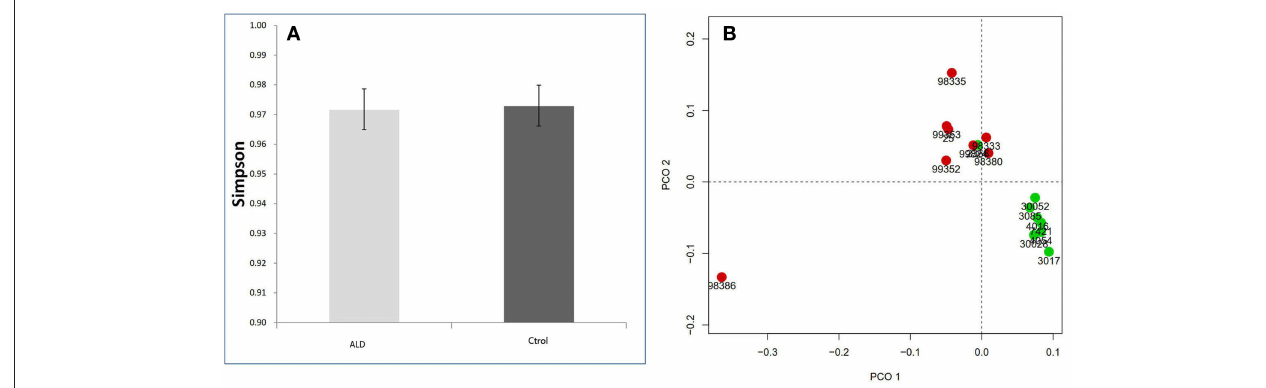
FIGURE 2 | (A) Simpson index based on the OTU counts. (B) PCA analysis based on unweighted Unifrac distance.